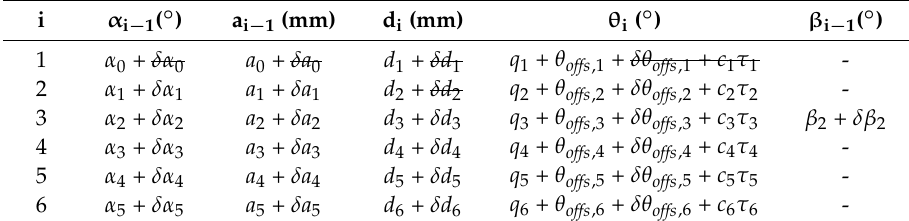
Table 5. Robot calibration parameters.